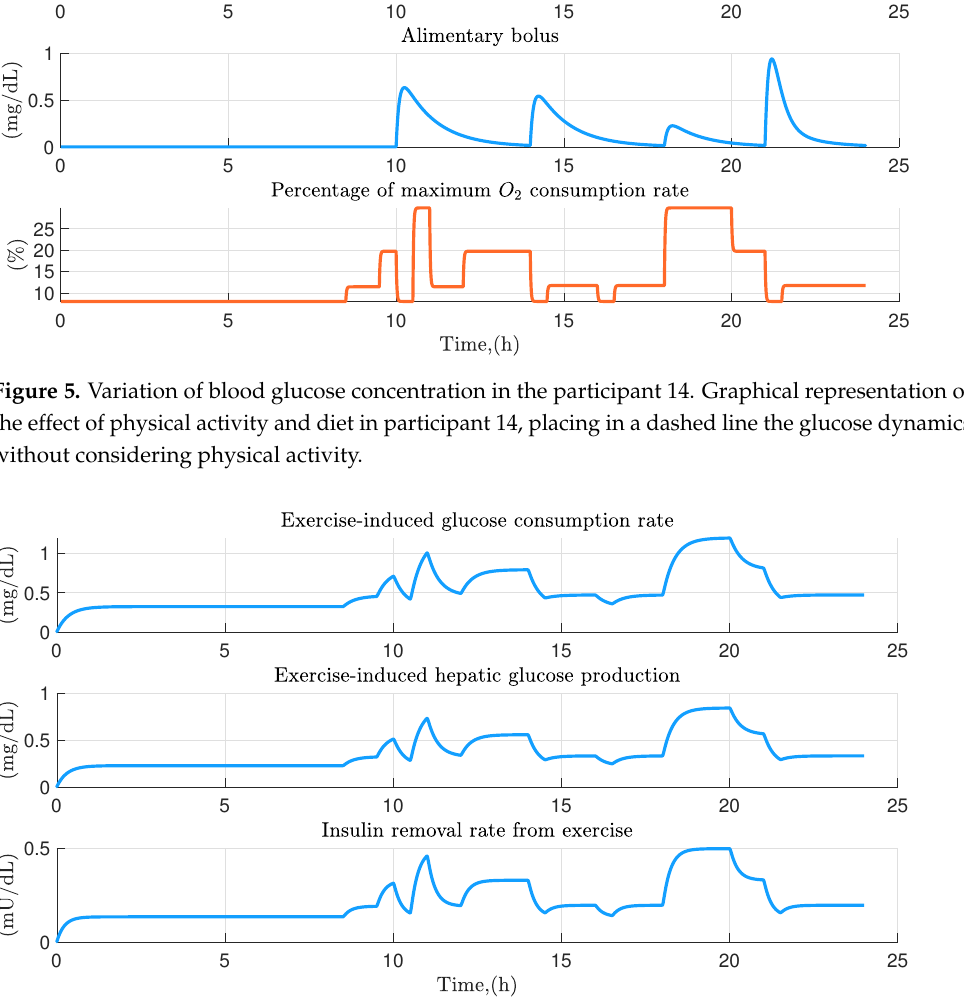
Figure 6. Exercise effect on the glucose homeostasis of the participant 14. Graphical representation of the reduction in glucose and insulin levels derived from the physical activity